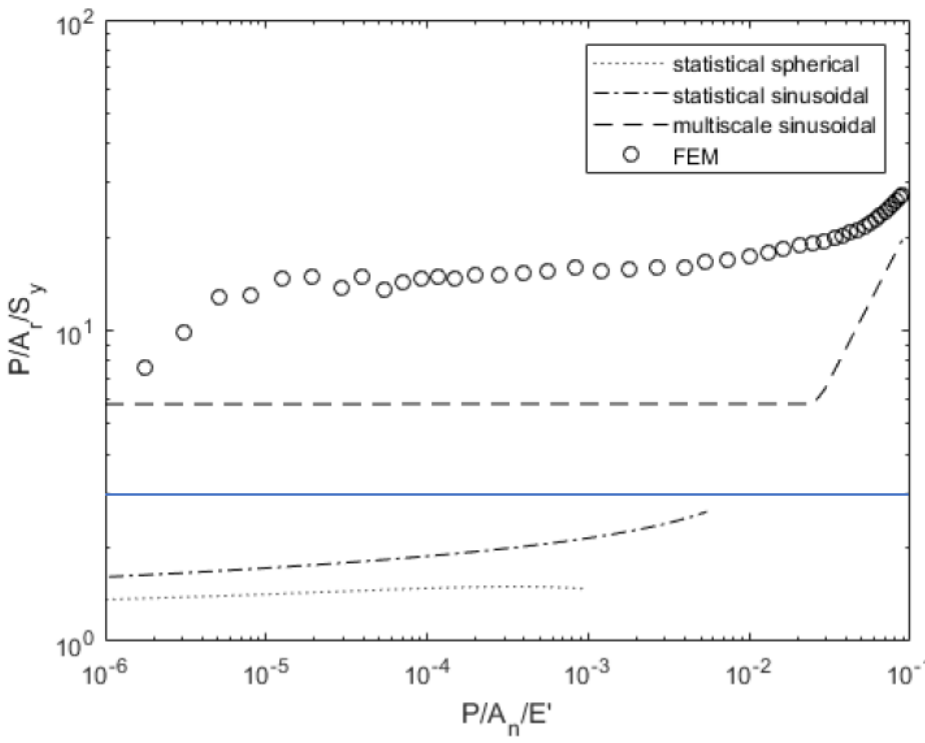
Figure 11. Load-dependent contact pressure variation for surface 63M.